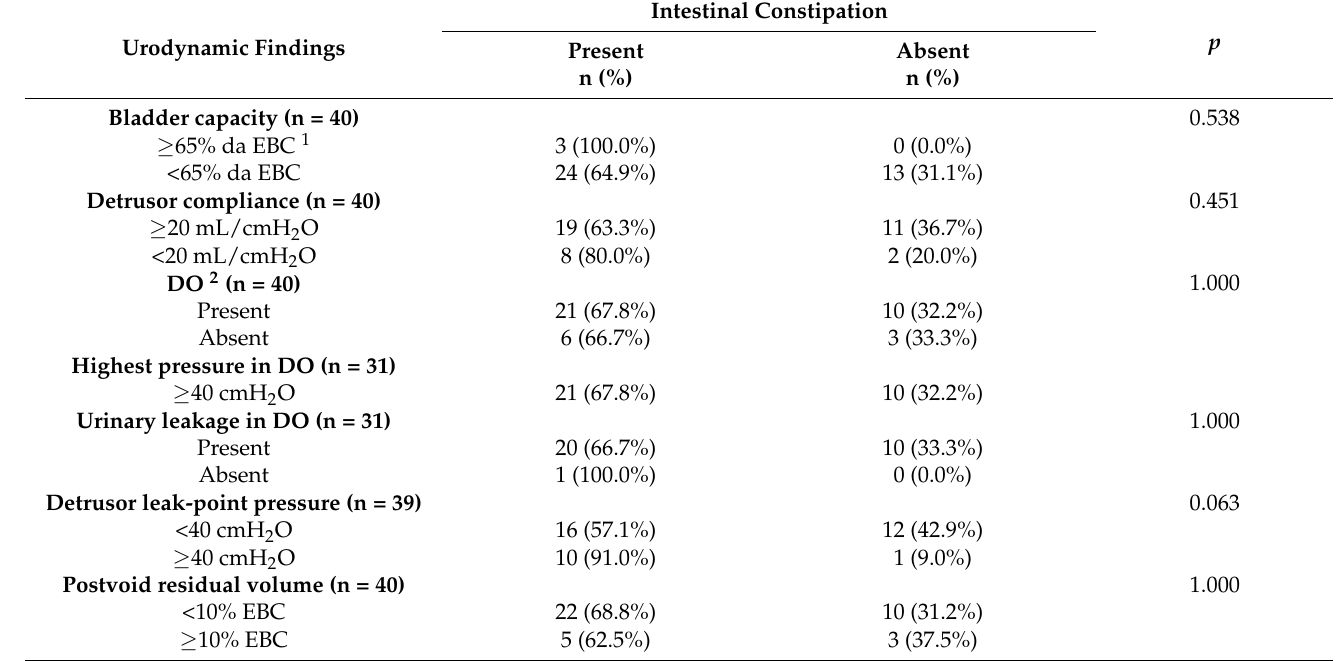
Table 4. Association between urodynamic findings and intestinal constipation in 40 children who underwent UDS at the OCUH-UPE from October 2018 to March 2020 as part of the